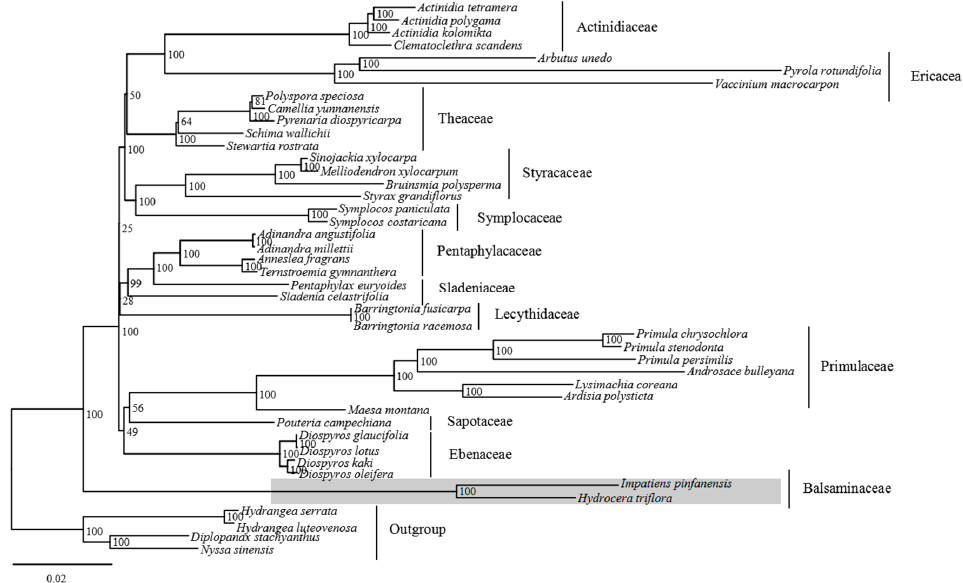
Figure 5. Phylogenetic relationships based on 51 common protein-coding genes of 38 representative species from order Ericales and four Cornales as Outgroup species with maximum likelihood. The numbers associated with the nodes indicate bootstrap values tested with 1000 replicates.